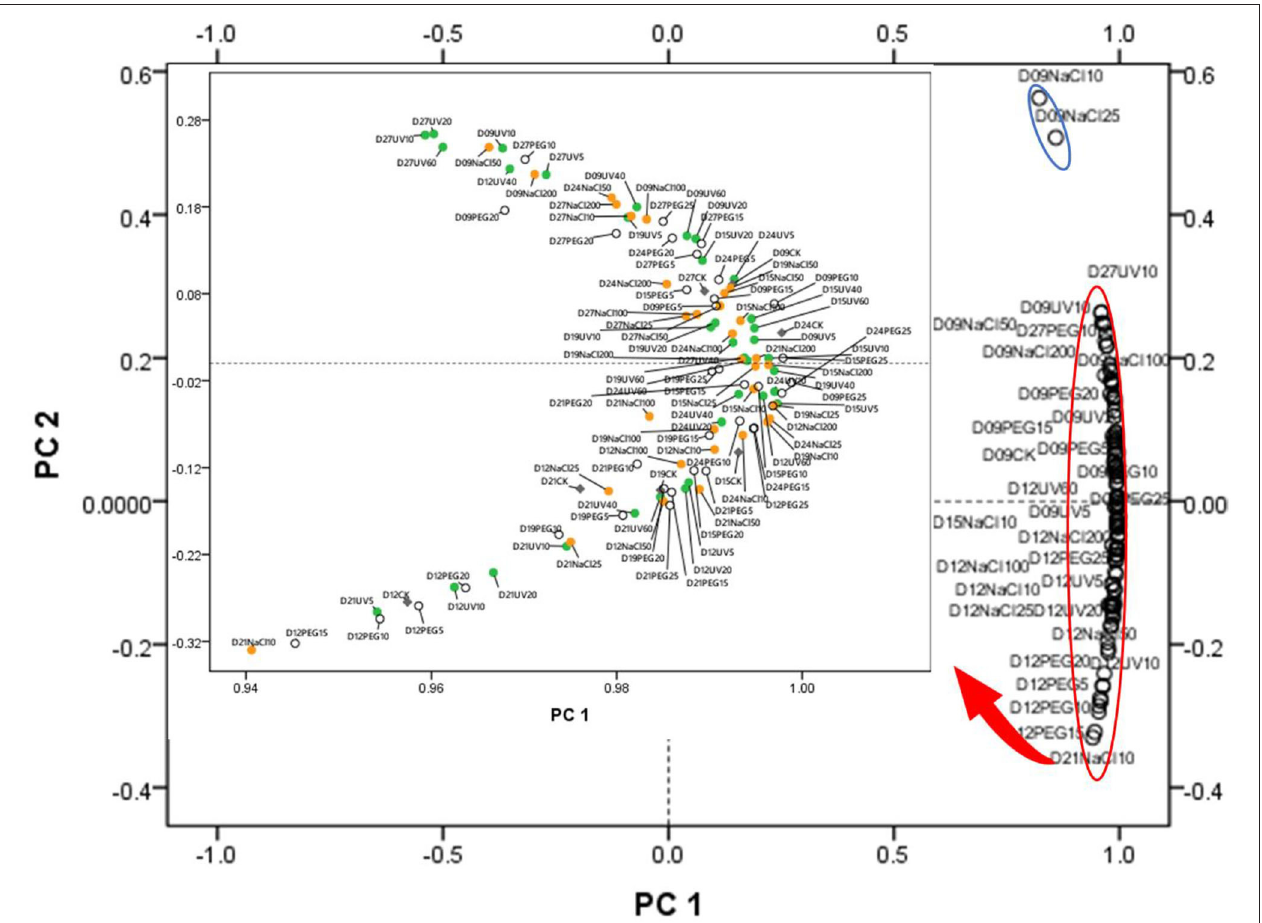
FIGURE 2 | Principal component analysis (PCA) of the abiotic stress (15 kinds of treatments and one control group) × seedling ages (from D9 to D27) interactions. PC 1 explained 96.527% of the variance which correlated with total polyphenol content (TPC), total flavonoid content (TFC), total triterpene content (TTC), ABTS, DPPH, and ferric ion reducing antioxidant power (FRAP), while PC 2 took up for 2.569% of the variance and correlated with total proanthocyanins content (TPAC), total Soluble polysaccharides content (TSPC), ascorbic acid content (AAC), and total chlorophyll content (TChl). The green dots represent the UV treatments, the orange dots represent the NaCl treatments, the blank dots mean the PEG treatments, and the gray ones mean the control group (CK). 59.87 > F (abiotictreatment) = 18.93, p < 0.01],